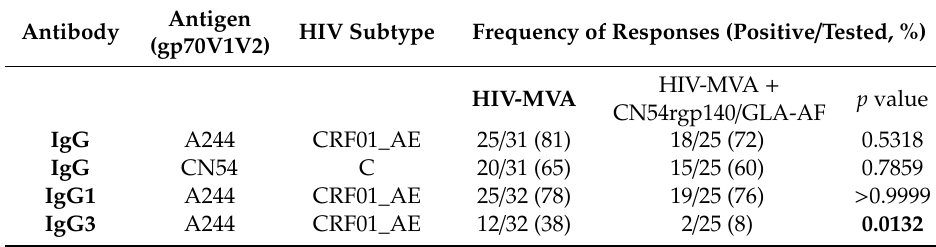
Table 3. Frequency of V1V2 antibody responses four weeks after the last